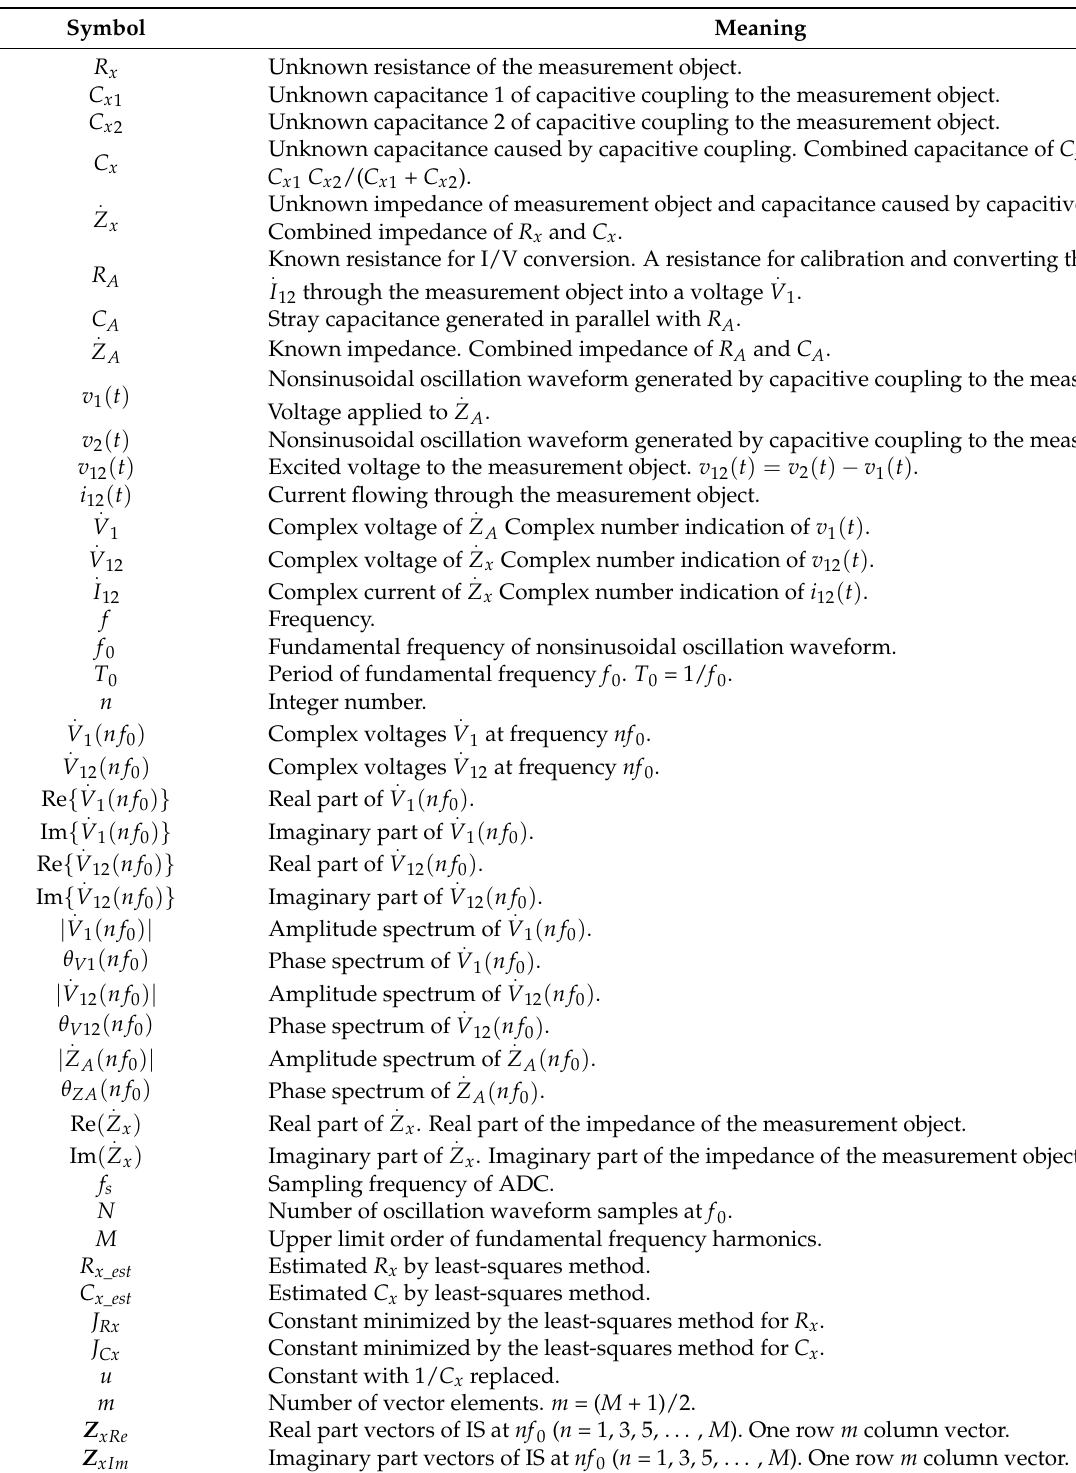
Table 1. List of